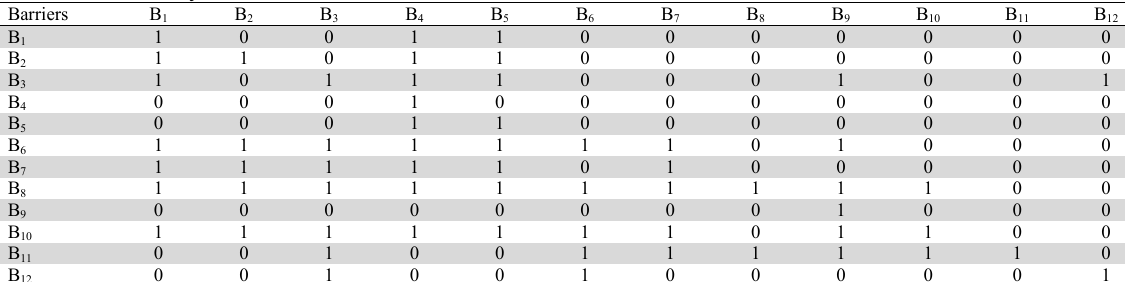
Structural self-interactive matrix (SSIM) Barriers with codes